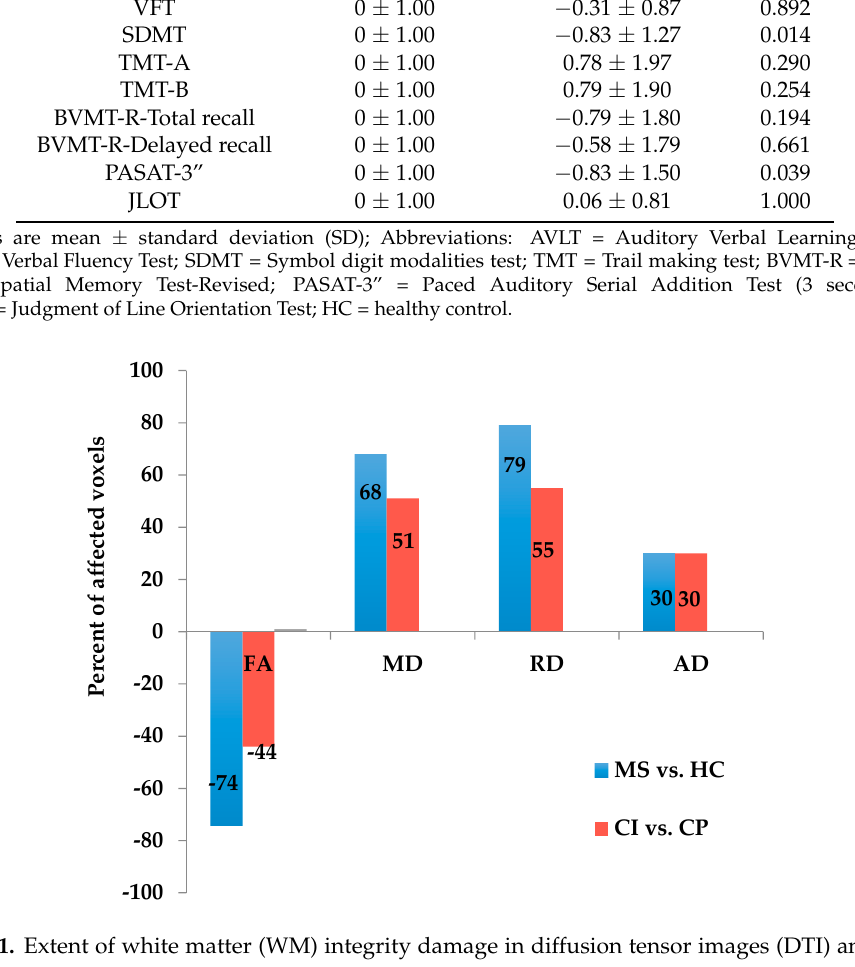
Figure 1. Extent of white matter (WM) integrity damage in diffusion tensor images (DTI) analyses. The bars indicate the extent of WM integrity damage. The blue and red bars indicate differences of WM diffusion between the multiple sclerosis (MS) patients and healthy control (HC) subjects, and between the cognitive impairment (CI) and cognitive preservation (CP) groups, respectively. FA, MD, RD, and AD refer to fractional anisotropy, mean diffusivity, radial diffusivity, and axial diffusivity, respectively. FA: fractional anisotropy; MD: mean diffusivity; RD: radial diffusivity; AD: axial diffusivity.